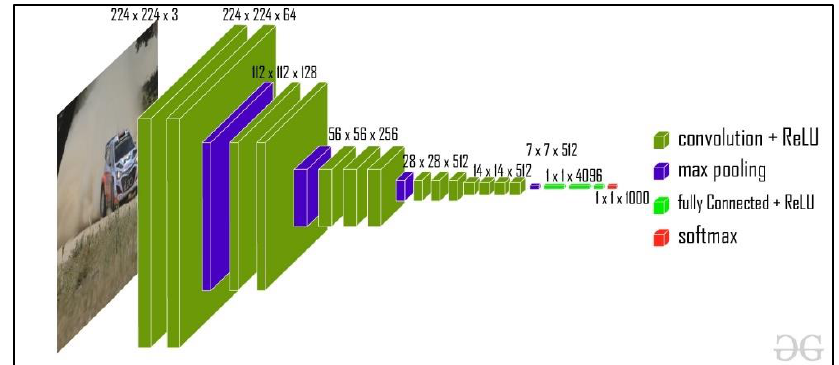
Figure 6. Presents the basic block diagram of VGG-16 model.